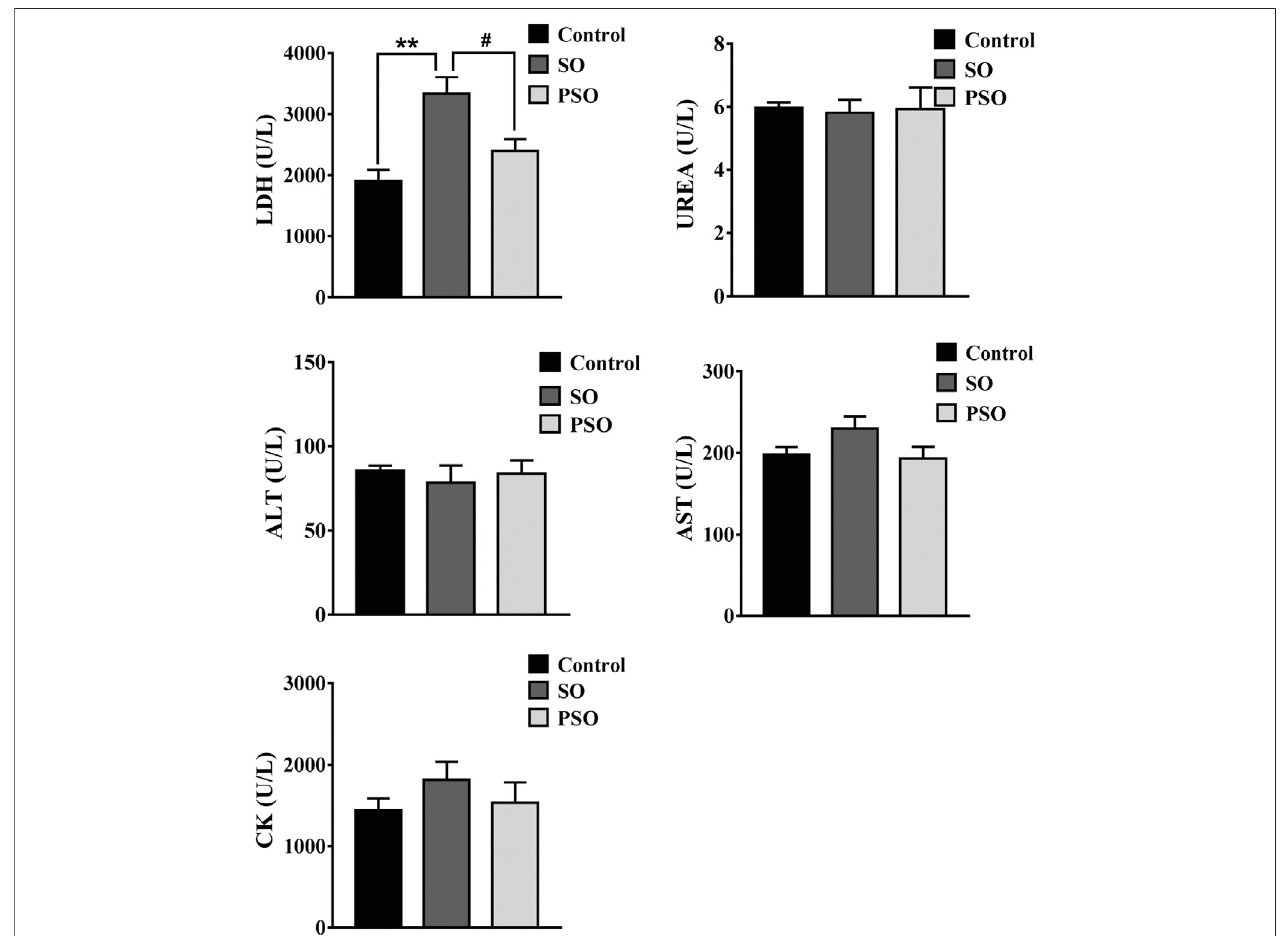
FIGURE 1 | Biochemical parameters in the serum of vehicle-, raw SO- and PSO-treated rats at month 6. ** p < 0.01 vs . control; # p < 0.05 vs. raw SO.